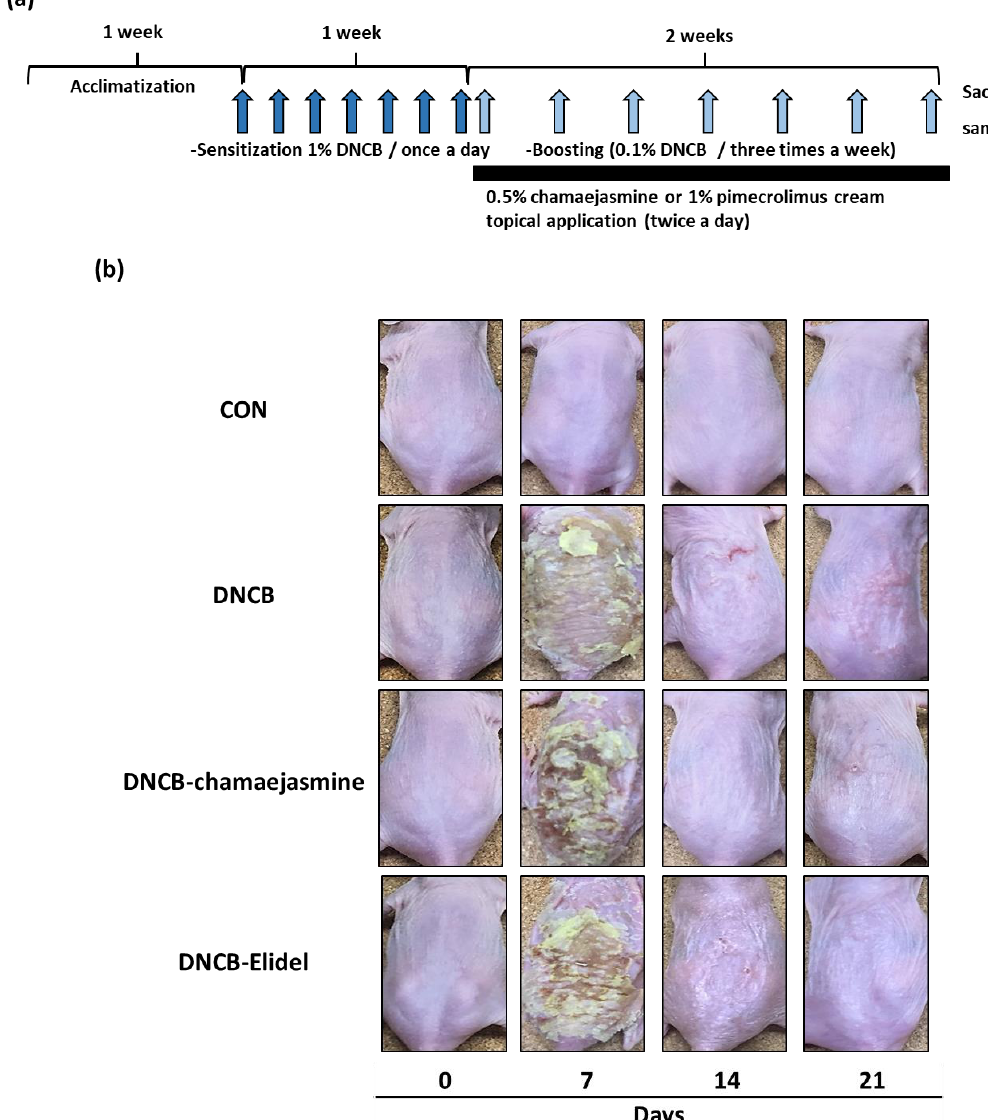
Figure 4. Effects of chamaejasmine on the development of DNCB-induced AD-like skin lesions in SKH-1 hairless mice. ( a ) Schematic representation of the experiment and ( b ) clinical features of DNCB-induced AD-like skin symptoms. CON: vehicle control group, DNCB: DNCB-treated control group, DNCB-chamaejasmine: DNCB and 0.5% chamaejasmine-treated group, DNCB-Elidel: DNCB and 1% pimecrolimus cream-treated group.